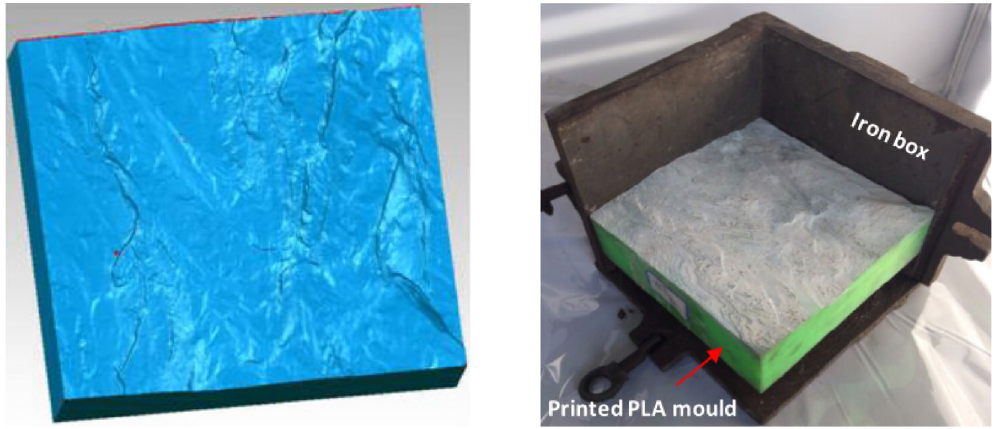
Fig. 2 Process of making a model with a natural structural plane (Jiang et al.